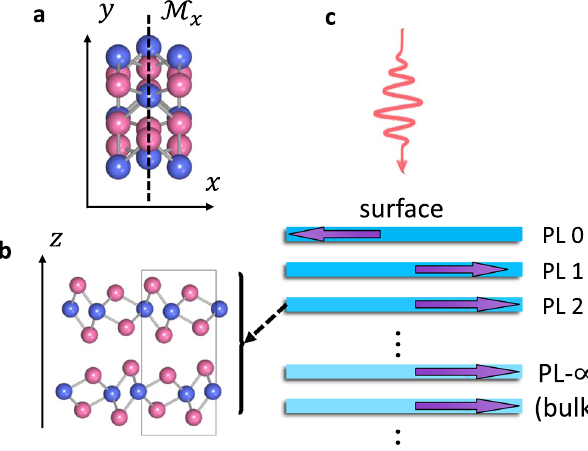
Fig. 1 Illustration of T d -WTe 2 under light illumination. a , b Atomic structure of T d -WTe 2 . The dashed line in a denotes the mirror- x symmetry M x of T d -WTe 2 . c A sketch of materials under light illumination. The surface and bulk principal layer (PL) corresponds to PL-0 and PL- ∞ , respectively. The optical responses of the surface and the bulk can be distinct (indicated by the purple arrows). For T d -WTe 2 , each PL consists of two WTe 2 layer without inversion symmetry as shown in b